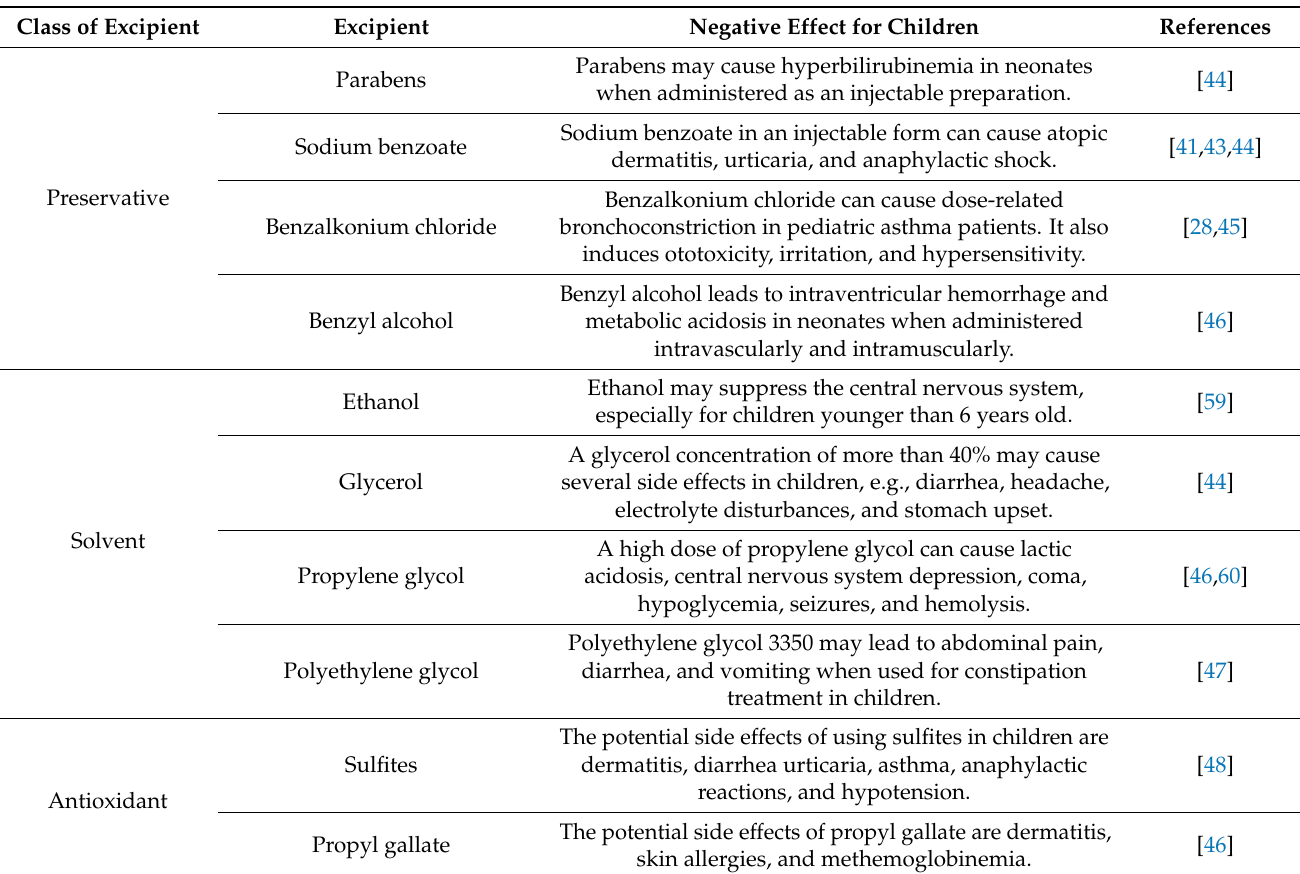
Table 2. Excipients of concern for